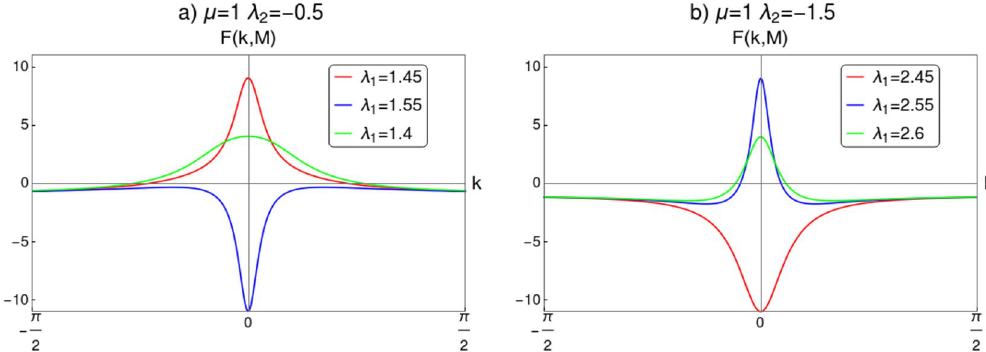
0 plotted for (cid:31) 2 < 0 . ( a ) Curvature function plotted Figure 5. Curvature function F ( k , M ) near the HSP k 0 = 0 and w 1 . ( b ) Curvature 1 and (cid:31) 2 0.5 for the transition between w for several values of (cid:31) 1 at µ = = = = − 2 and w 1 . 1 and (cid:31) 2 1.5 for the transition between w function plotted for several values of (cid:31) 1 at µ = = = = − In both ( a ) and ( b ) the plot is around the QCPs, which defines the topological transition between gapped phases. As the QCP is approached, curvature function diverges at HSP and flips sign as we cross it. The scaling F ( k δ k , M ) is procedure proposed in CRG will fit here since the condition F ( k 0 , M ′ ) 0 = + µ , (cid:31) 1 , (cid:31) 2 where M . Behavior of F ( k , M ) near the QCPs for the transition between gapped phases is shown in } = { 0 and w 1 is shown in Fig. 5a for the parameter values (cid:31) 2 1 . 0.5 and µ Fig. 5. The transition between w = = = = − 0 . In Fig. 5b, curvature function for transition 1.5 at k 0 For this transition critical point is obtained for (cid:31) 1 = = 2 and w 1 for parameter values (cid:31) 2 1 is shown, where the critical point appear 1.5 and µ between w = = = = − 0 . Curvature function tend to diverge as we approach the critical points and flips sign as 2.5 at k 0 for (cid:31) 1 = = 0 . RG we cross it. This confirms that F ( k , M ) takes the Ornstein–Zernike form of Eq. (9) around the HSP k 0 = flow equations can be constructed now to see the flow line’s behavior in the parameter space to understand the 0 as (refer to “Method” section topological transition in the model. The RG equations can be derived for k 0 = for a detailed derivation)